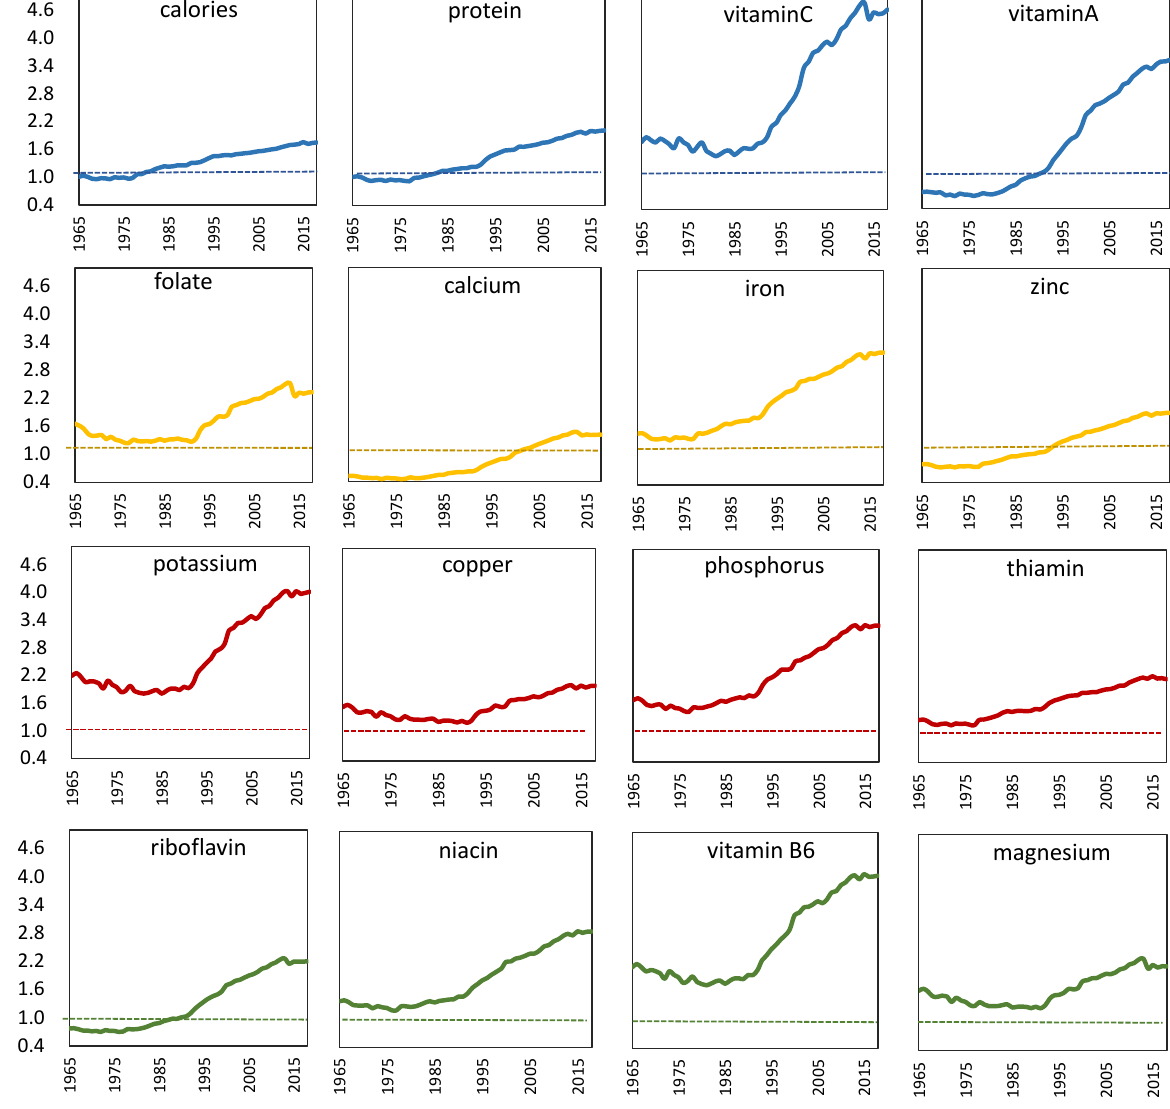
Figure 2. The supply adequacy of different nutrients for Chinese residents from 1965 to 2018. Aquatic products, nuts, and dairy products are respectively rich in copper, magnesium, and riboflavin. It is found that Chinese residents have less intake of aquatic products, nuts and dairy products, making the corresponding nutrient supply